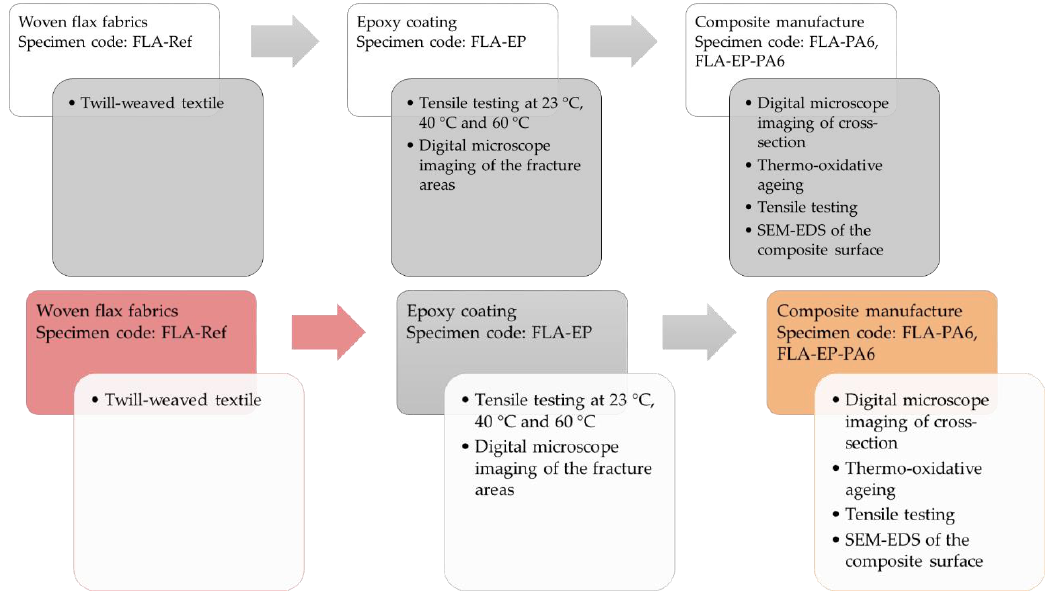
Figure 1. The main steps of the study and the nomenclature of the manufactured samples: flax reference (FLA-Ref), epoxy-coated flax, (FLA-EP), flax-reinforced polyamide 6 (FLA-PA6) and polyamide 6 reinforced with epoxy-coated flax (FLA-EP-PA6).